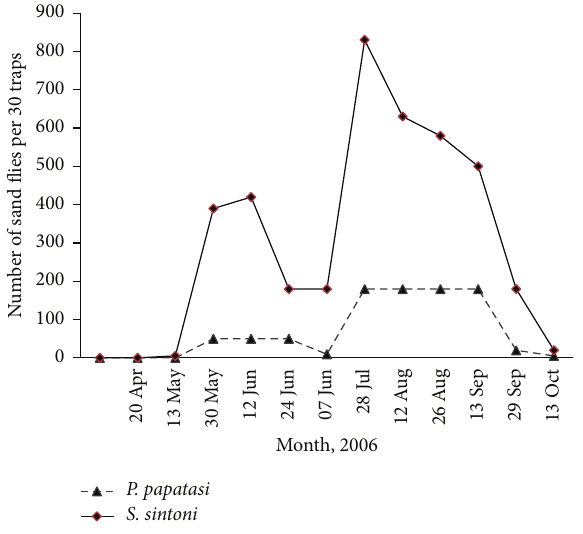
Figure 3: Monthly activity of Se. sintoni, Ph. papatasi outdoors of Khatam County, Yazd Province, central Iran,